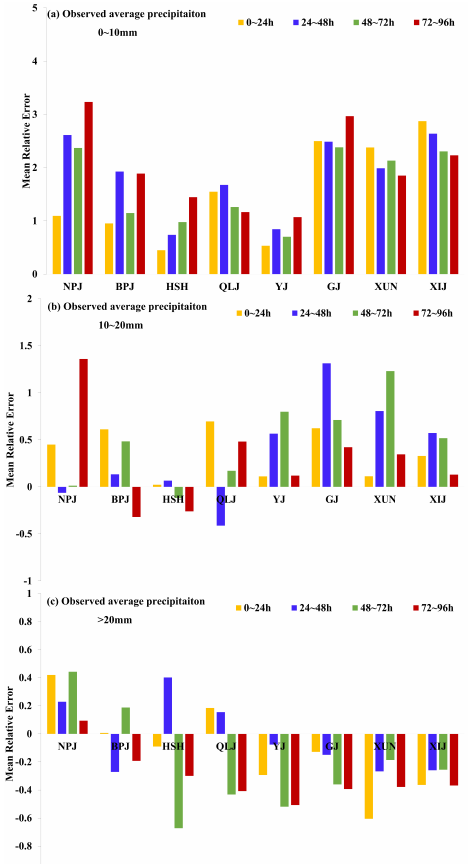
Figure 12. Mean relative error (MRE) of areal average forecast (yellow bars = 0–24 h; blue bars = 24–48 h; green bars = 48–72 h; red bars = 72–96 h) precipitation (( a ) 0–10 mm; ( b ) 10–20 mm; ( c ) > 20 mm) for each sub-basin (BPJ = Beipanjiang; NPJ = Nanpanjiang; QLJ = Qianjiang–Liujiang; YJ = Yujiang; GJ = Guijiang; XUN = Xunjiang; XIJ =